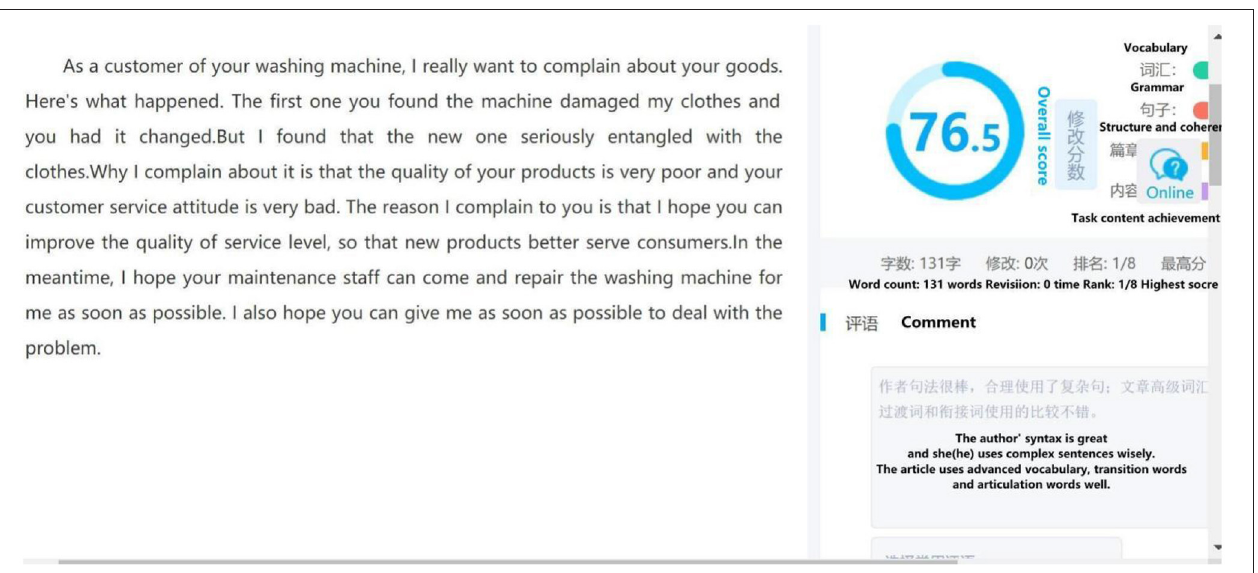
FIGURE 4 | Pigai—Automatic writing evaluation